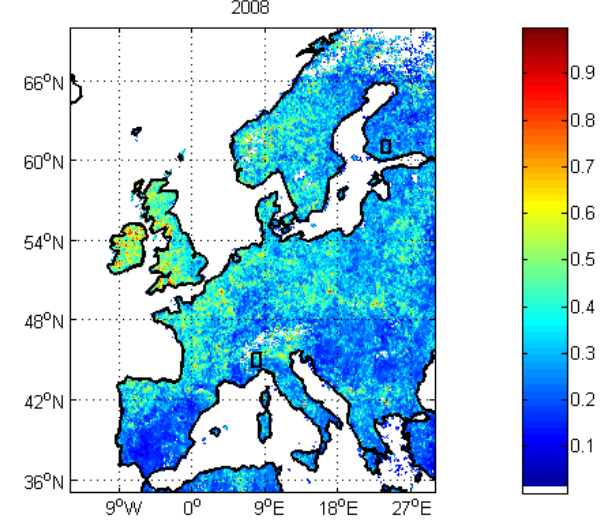
Fig. 11. AOD at 555nm over Europe, as an aggregate of the in- dividual data for the whole year 2008. White areas (e.g. over the Alps) indicate the absence of